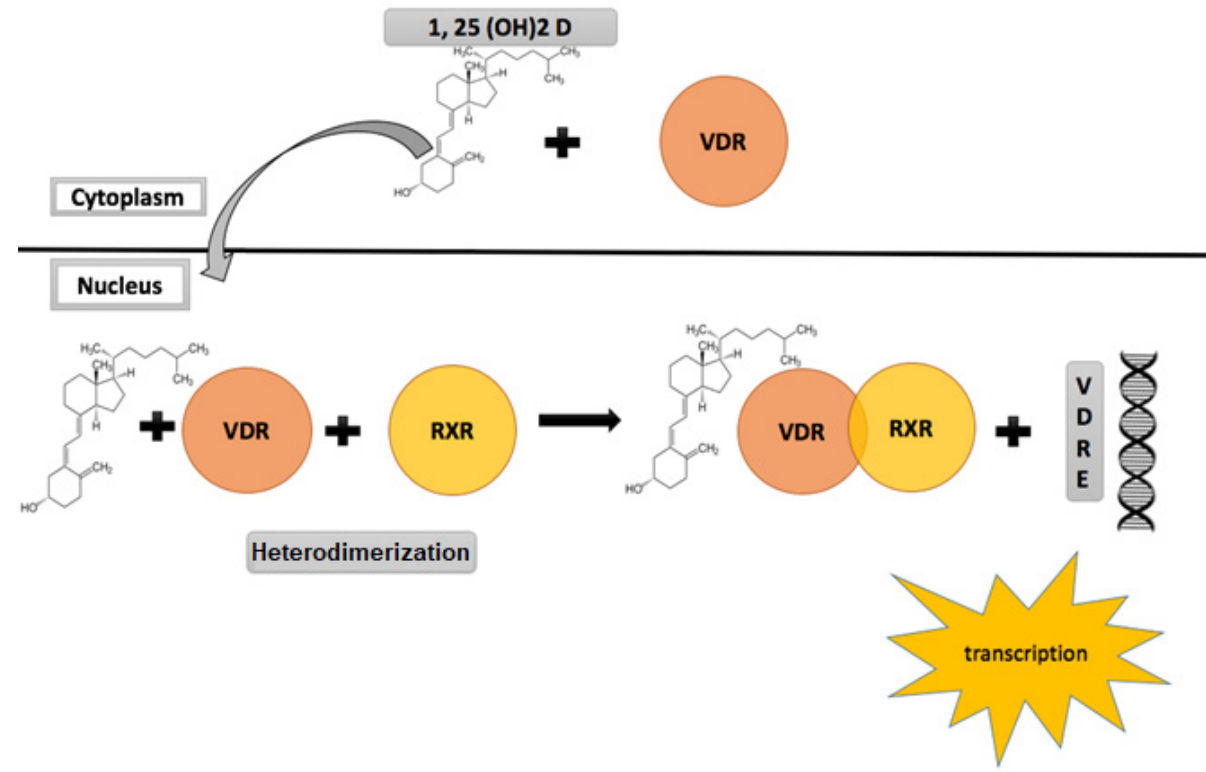
Figure 2. Vitamin D receptor (VDR) signalling and activation.